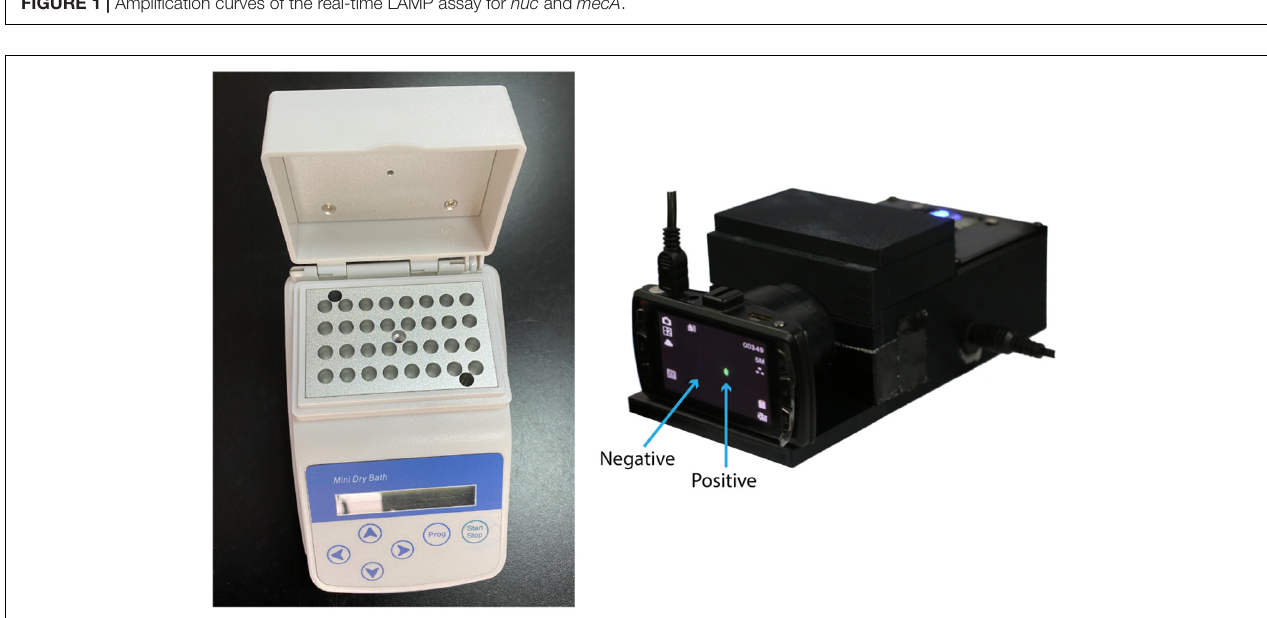
FIGURE 2 | Portable equipment for the LAMP assay and fluorescence